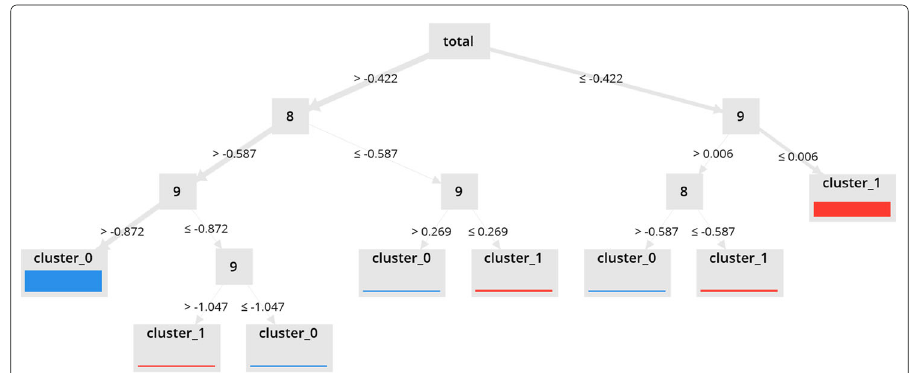
Fig. 2 Cluster tree of k -means in RapidMiner